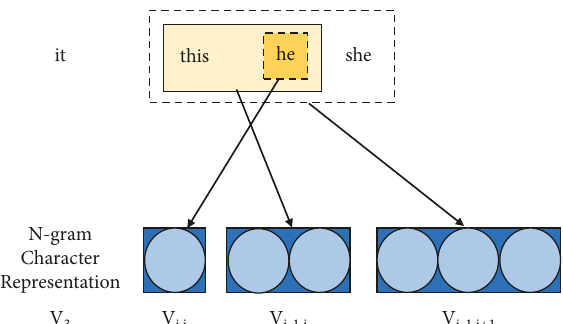
Figure 3: Gated loop unit.